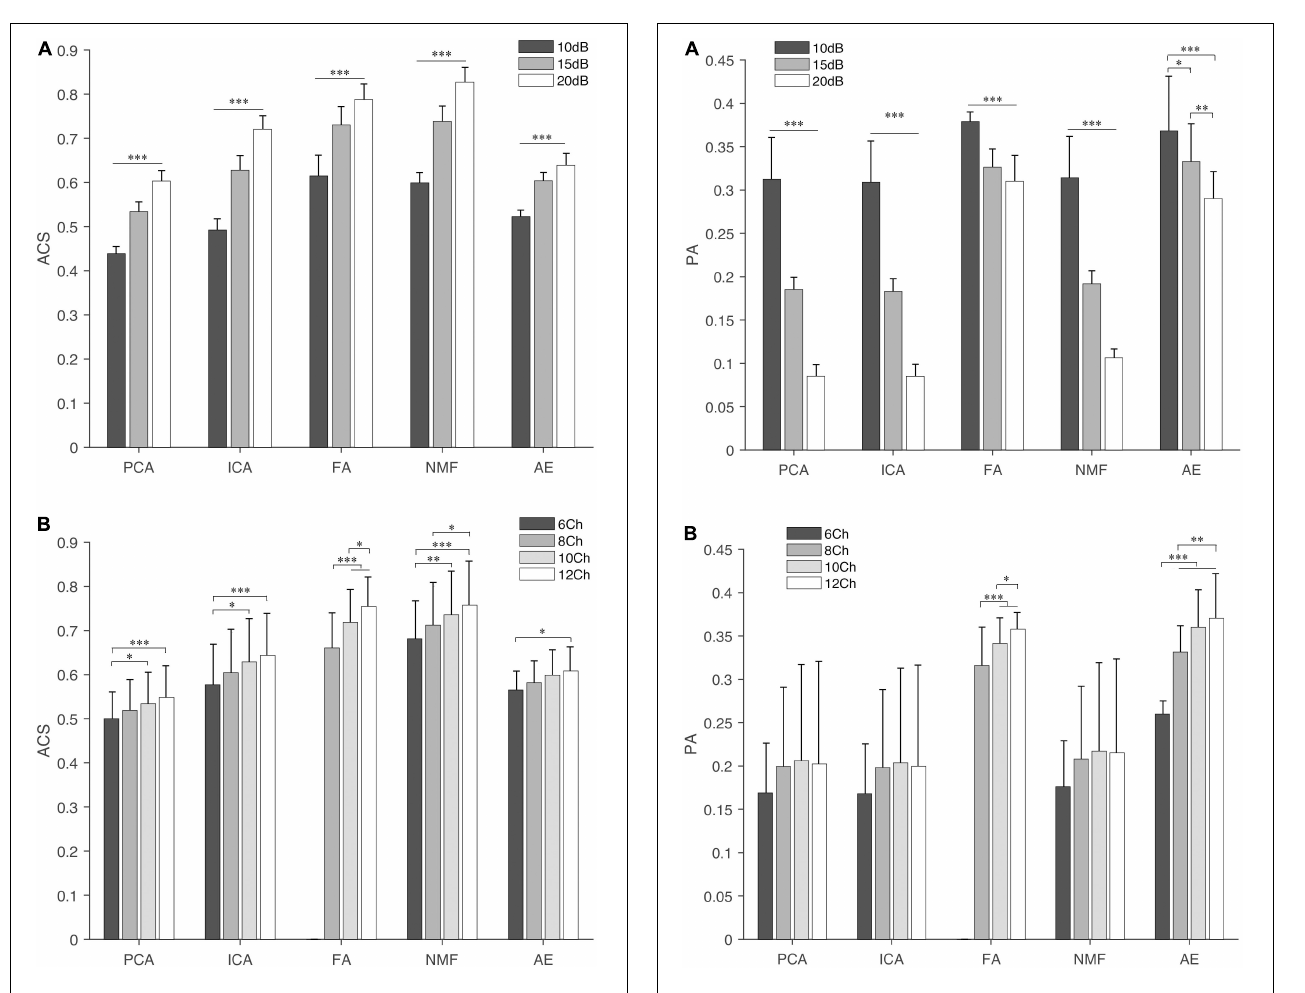
EMG signals) and outputs (synergies and activation coefficients).